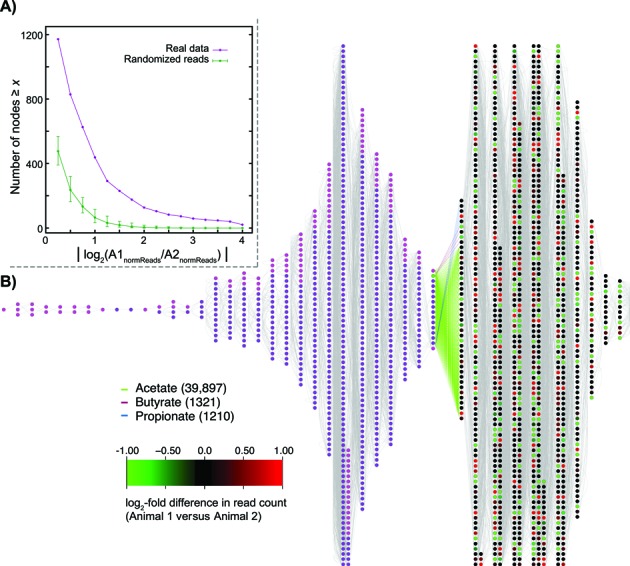
Node-level differences between animals and volatile fatty acid metabolism. (A) The two animals studied differ considerably the relative abundance of many enzyme-coding genes. On the x-axis is the absolute value of the log2 difference in enzyme abundance for the two animals, after correcting for the different number of reads obtained for the two animals. Hence, a value of 2 on this axis represents a four-fold excess of reads mapping to a particular node either in animal 1 over animal 2 relative to the other animal. On the y-axis is the number of nodes seen to have a log2 abundance difference at least as large as x (purple curve, real data). For comparison, we show the number of such nodes seen when we randomly reassign reads to animals 1000 times (green curve; error bars represent the maximum and minimum numbers seen across all 1000 randomizations. (B) Enzymes involving the volatile fatty acids (VFAs) represent a minor fraction of the metagenomic reads. Host/microbe merged metabolic networks when only the three VFAs were considered as interface metabolites (N50). All other details are as for Figure 2A. Note that the network is much smaller (fewer reactions are linked between the host and the microbes). Moreover, even these linkages are weaker, since the number of mapped reads to the distance 0 microbial nodes is much lower than in Figure 2A—glutamate alone accounts for roughly four times as many reads as are present in the entire ‘layer’ for this network.